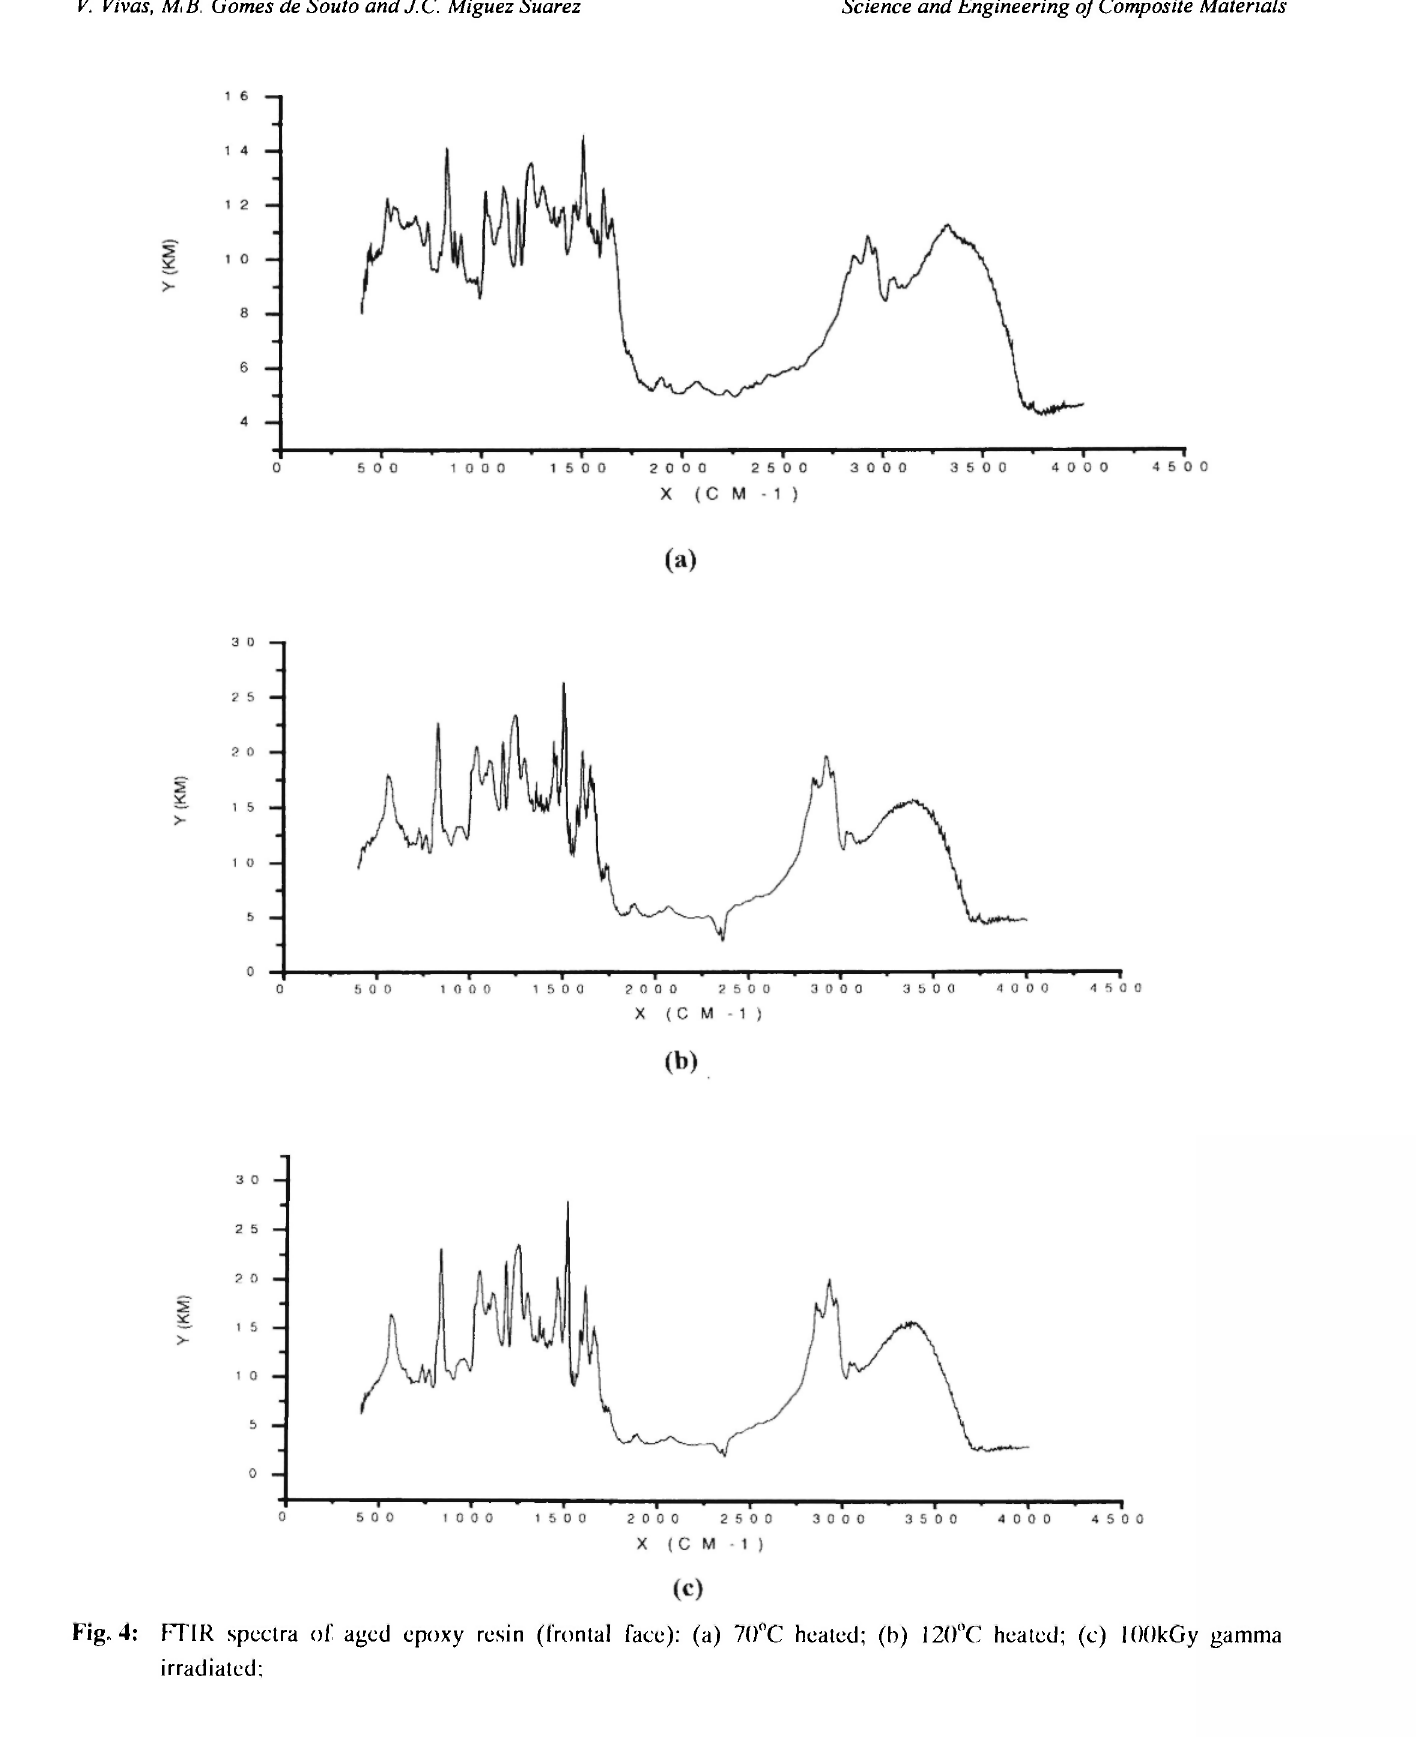
Fig. 4: fTIR spectra of aged epoxy resin (frontal face): (a) 70"C heated; (h) 120°C heated; (c) lOOkGy gamma irradiated;